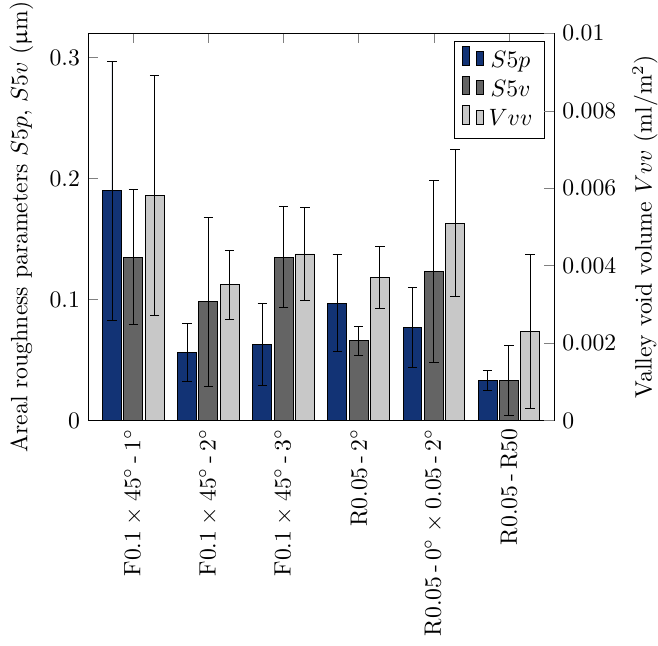
Figure 5. Areal and volumetric surface parameters of the generated surfaces depending on tool cutting edge angle, corner geometry, and minor cutting edge geometry ( v c = 250m/min, f z = 0.015mm, a p = 0.25mm, a e =